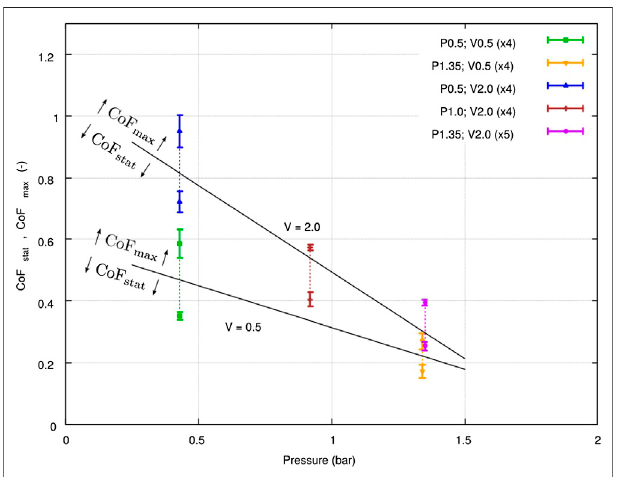
FIGURE12| Results ofinter-ply slidingtest: maximum andstatic friction coef fi cients vs. pressure.